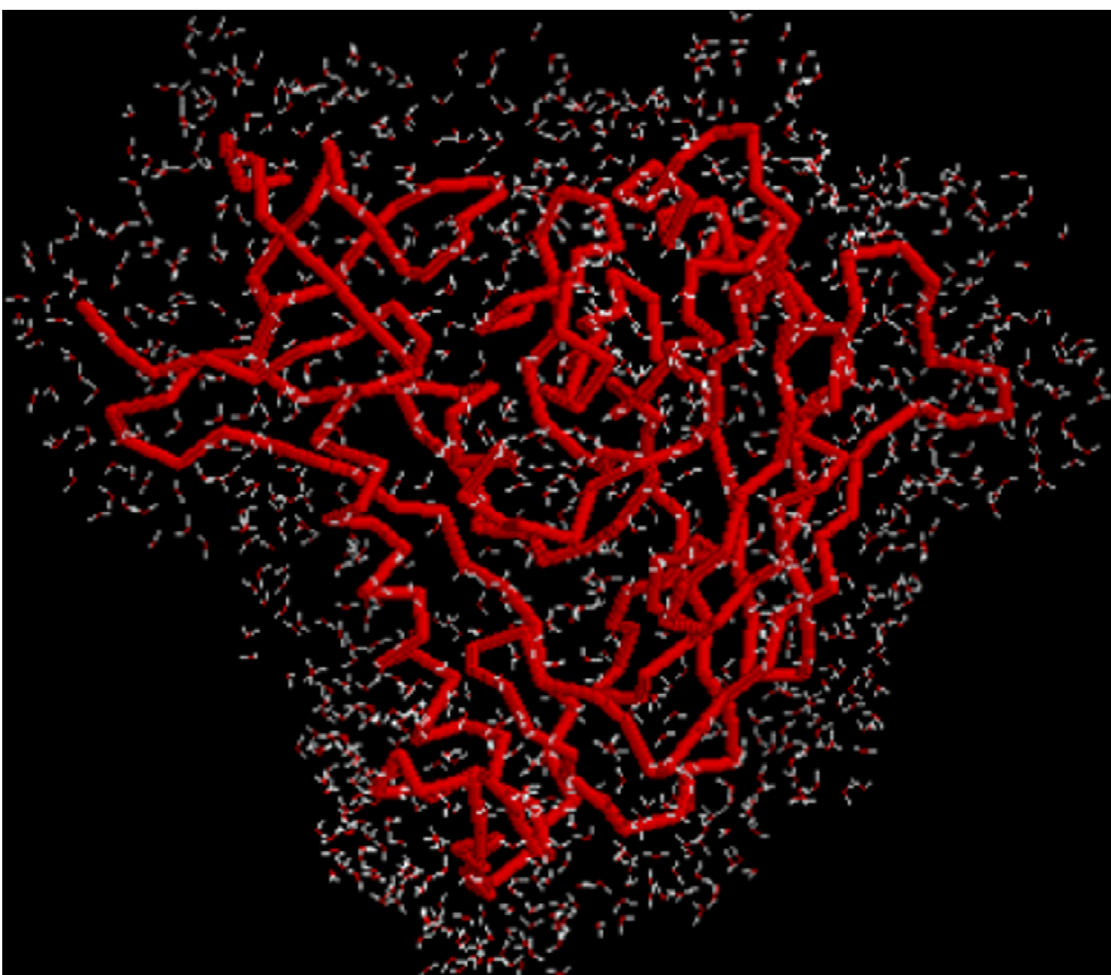
Figure 13. The solvent shell for molecular dynamic simulation of HIV gp120. The isolated gp120 molecule is shown as a backbone worm and the 1150 TIP3P water molecules are shown as oxygen ball (red) and O-H bond sticks (white). doi:10.1371/journal.pone.0052170.g013 Hessian Matrix. The DIMB method does repetitive reduced-basis diagonalizations and uses less memory compared to the conven- tional diagonalization but yields exactly the same eigenvalues and eigenvectors as for the conventional diagonalization methods. Only the first 250 normal modes, whose frequency values were less than 50 cm 2 1 , were computed with an eigenvalue and eigenvector accuracy tolerance level of 0.05.